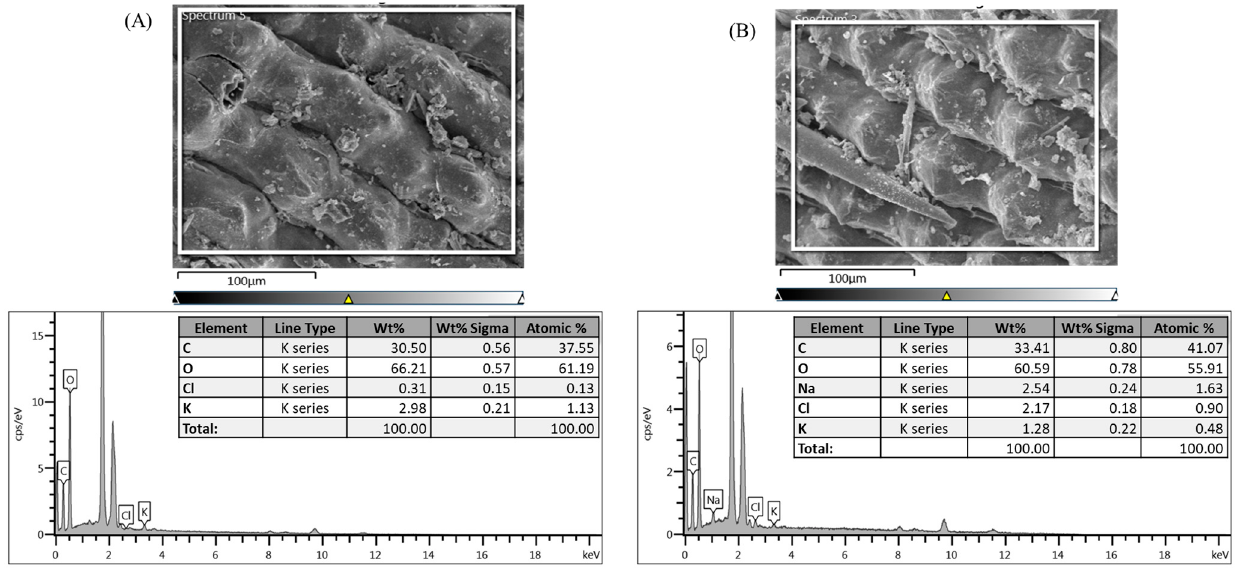
Figure 6. Scanning electron microscopy (SEM) images and X-ray spectroscopy (EDX) spectra of rice husk biochar before ( A ) and after being added to saline soil ( B ). husk biochar before ( A ) and after being added to saline soil ( B